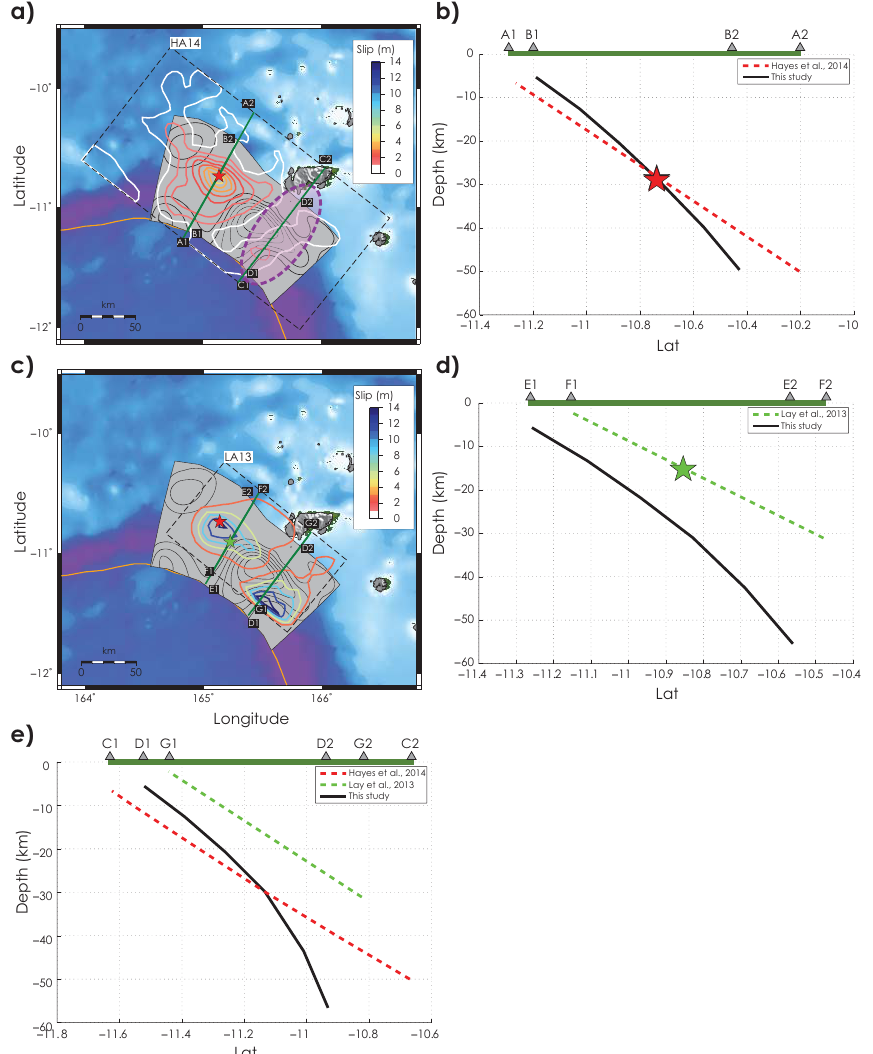
Figure 6. Comparison with other source models. (a) HA14 model (coloured solid lines at 0.5m intervals); magenta ellipse approximately represents the aseismic slip area hypothesized in HA14; black solid lines as in Fig. 4; green solid lines represent the surface projections of the depth profiles along the HA14 fault model and the one adopted in this study. (b) Depth profiles along the HA14 fault model (red) and the one adopted in this study (black), crossing the hypocentre used in HA14 (red star) and in this study (black star); notice the the two hypocentres are almost coincident. (c) LA13 model (coloured solid lines at 2.8m intervals); black solid lines as in Fig. 4; green solid lines represent the surface projections of the depth profiles along the LA13 fault model and the one adopted in this study. (d) Depth profiles along the LA13 fault model (green) and the one adopted in this study (black), crossing the hypocentre used in LA13 (green star). (e) Depth profiles along the LA13 and HA14 fault models and the one adopted in this study, crossing the aseismic slip area hypothesized in